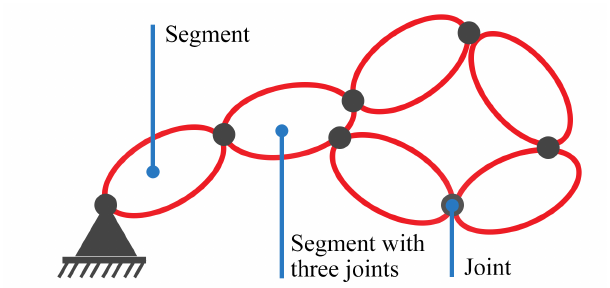
Figure 1. Closed kinematic